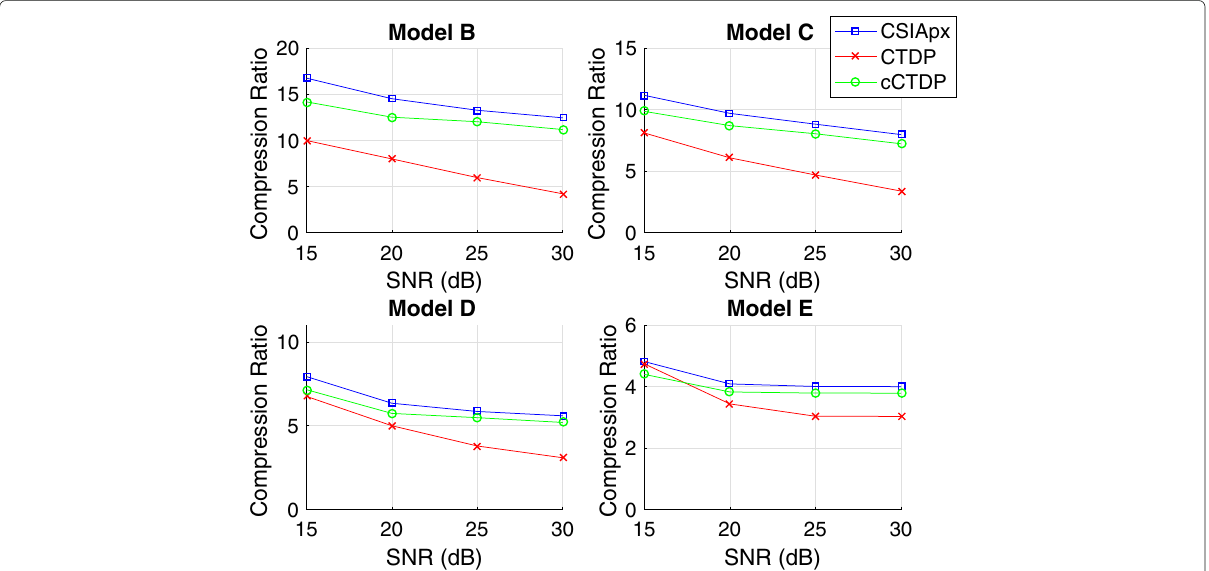
Fig. 10 Compression ratio with model data. The mean of the fit residual per point is shown when running CSIApx versus CTDP versus CCTDP on the synthesized CSI data across four channel models B, C, D, and E and four SNR values 15 dB, 20 dB, 25 dB, and 30 dB